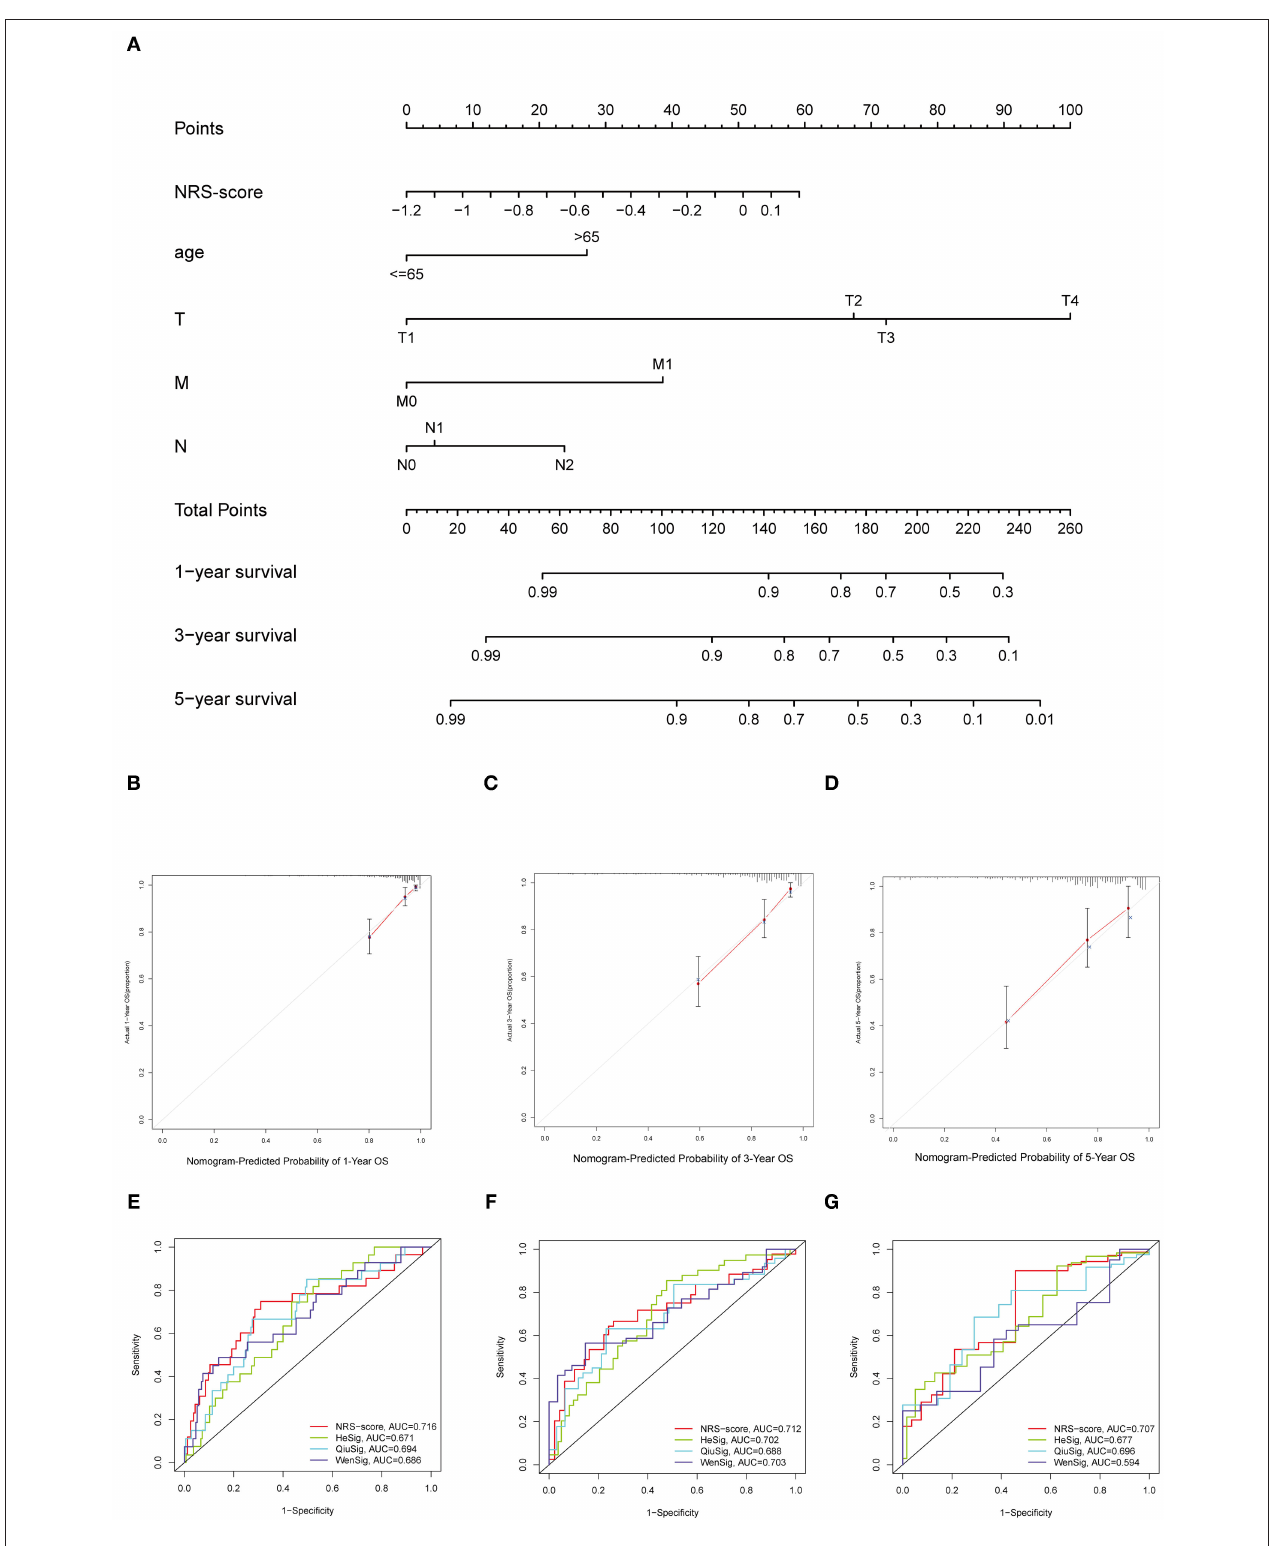
FIGURE 6 | Establishment of the nomogram for predicting overall survival for patients with colon cancer. (A) Nomogram based on prognostic signature for predicting 1-, 3-, and 5-year survival in patients in colon cancer. (B–D) Calibration curves of nomogram for predicting (B) 1-year, (C) 3-year, and (D) 5-year survival. (E–G) Comparison of the area under the time-dependent ROC curves for NRS-score, HeSig, QiuSig, and WenSig at (E) 1-, (F) 3-, and (G) 5-years OS.